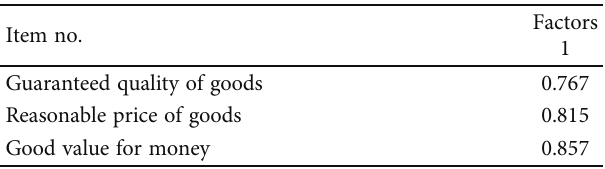
Table 5: Customer perceived value factor loadings.